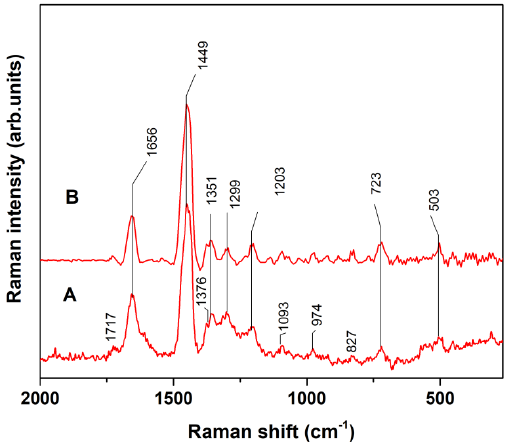
Figure 3. Comparison of Raman spectra of fossil resin from Dominican Republic (Santiago de los Caballeros) collected with laboratory (A) and handheld (B) equipment.